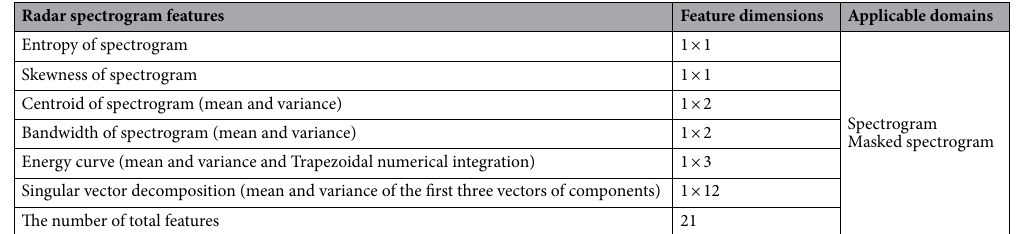
Table 3. 21 radar features and their data domains.